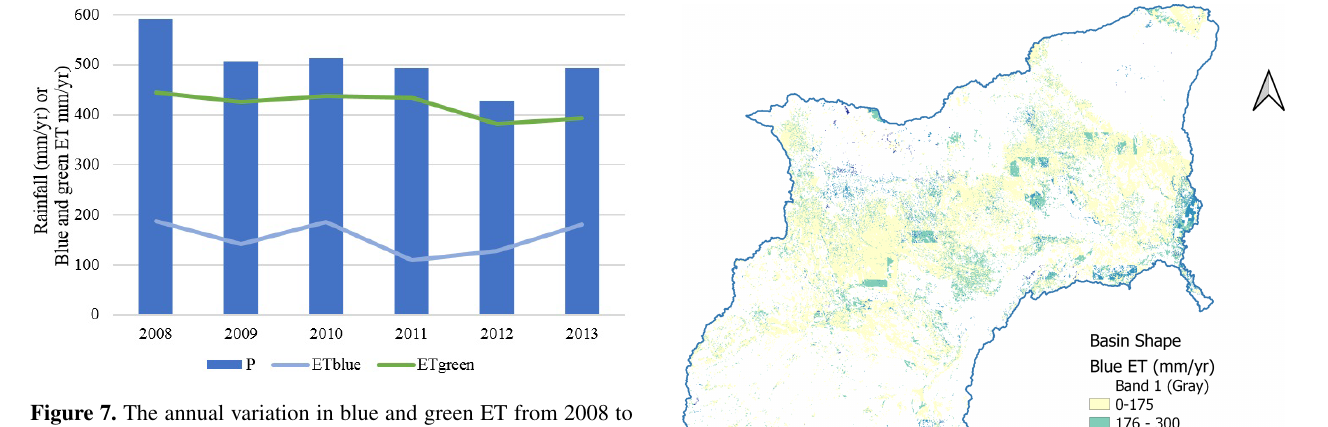
Figure 7. The annual variation in blue and green ET from 2008 to 2013.